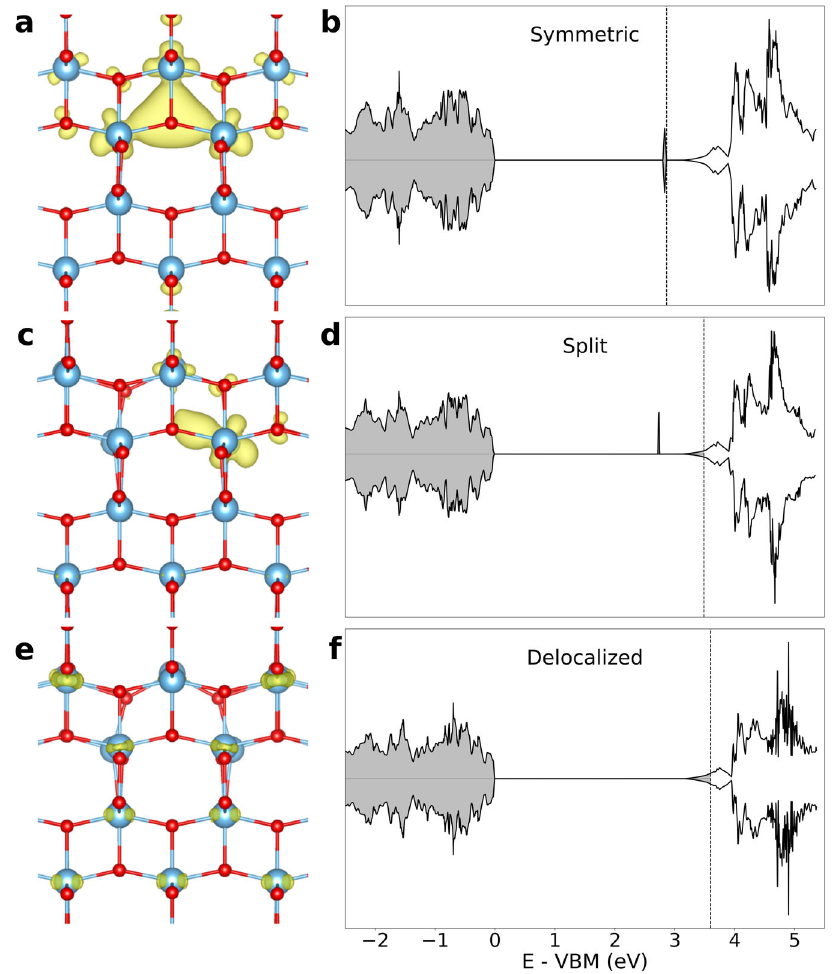
Fig. 8 Electronic structure of the possible (meta)stable □ O con fi gurations in TiO 2 anatase. Isosurfaces for: a the simple vacancy, c the split vacancy, and e the delocalized vacancy plotted for the valence electron density projected onto the defect-induced level. Isosurfaces levels are shown at 0.005 e Å − 3 . Electronic density of states for these con fi gurations, calculated at the HSE15 level using a 2 × 2 × 2 k -point mesh: b the simple vacancy, d the split vacancy, and f the delocalized vacancy. The dotted lines represent the Fermi level. The gray areas emphasize occupied states. The energy is referenced with respect to the valence band maximum